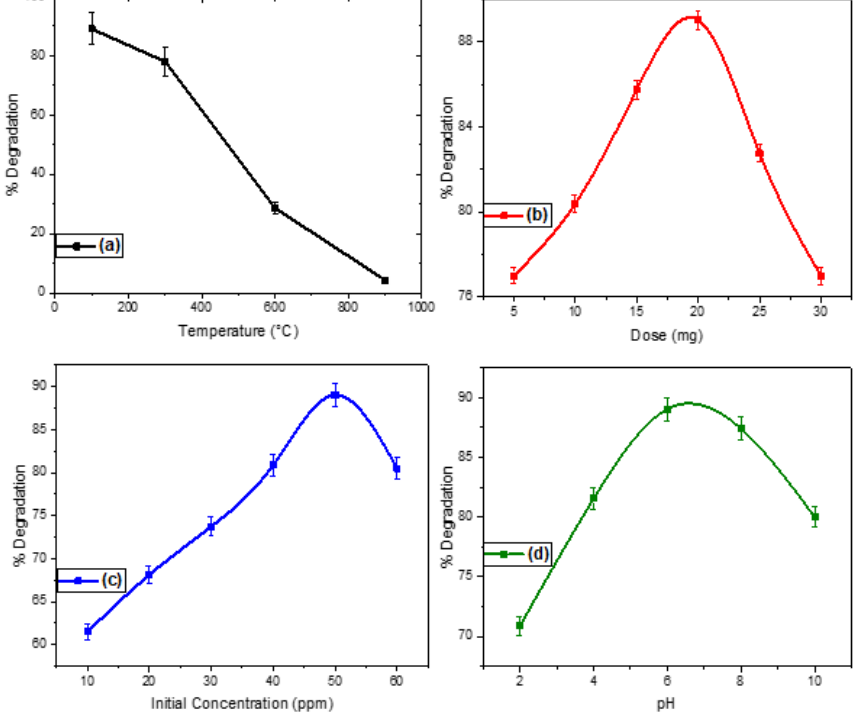
Figure 8. Effect of ( a ) annealing temperature (100–900 ◦ C), ( b ) pH (2–10), ( c ) catalyst dose (5–30 mg), and ( d ) initial methyl orange (MO) concentration (10–60 ppm) on the NiO-SnO 2 NC-induced photodegradation of MO. For each effect to be analyzed, all other variables were optimized and kept constant.